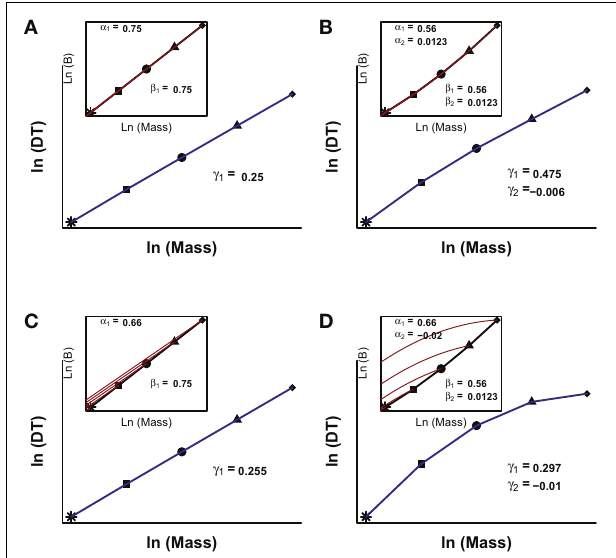
FIGURE 4 | Numerical solutions for Equation 6. The inset in each panel represents the interspecific (black line) and ontogenetic (red lines) scalings of B vs. body size. The different symbols represent hypothetical adult body sizes of different species. The blue lines show the scaling of developmental time (DT, defined as the moment in which the organism reach an arbitrary fraction of adult body size) with body mass. The coefficients shown correspond to the models ln( B ontogenetic ) = a o + α 1 ∗ ln( m ) + α 2 ∗ ln( m ) 2 ; ln(